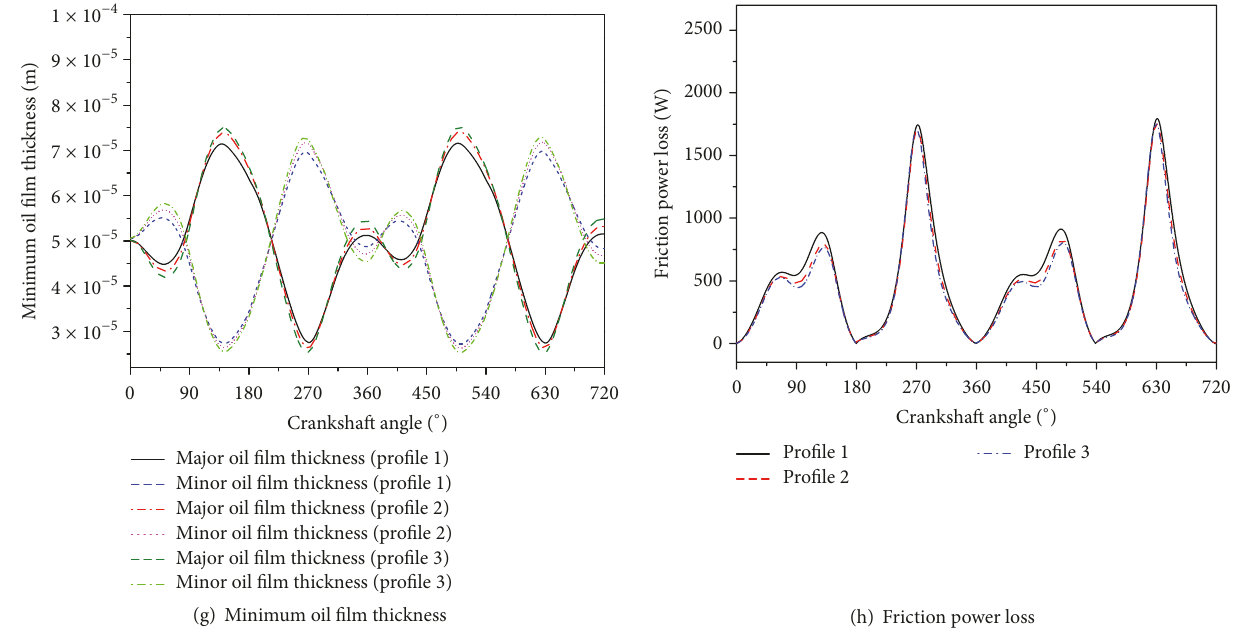
Figure 12: Effect of longitudinal profile on lubrication performance.